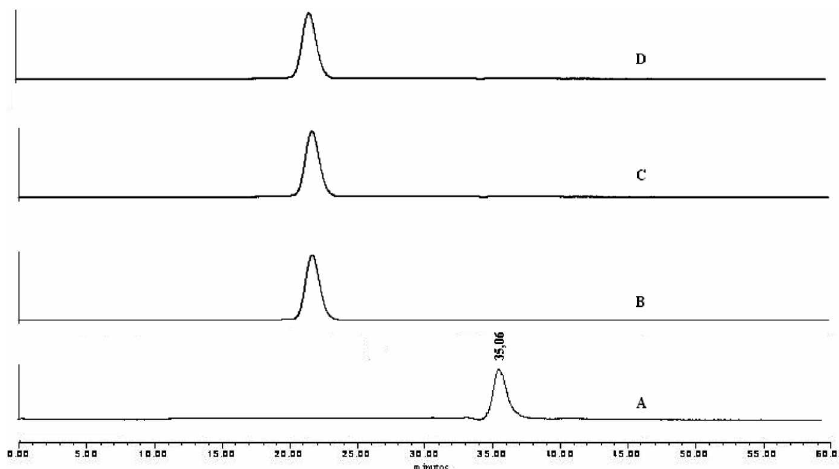
Figure 2 - UV Chromatogram profile (A) B- b -Ala-BBN; (B) SA: B- b -Ala-BBN (1:1); (C) SA: B- b -Ala-BBN (1:2); (D) SA: B- b -Ala-BBN (1:3).